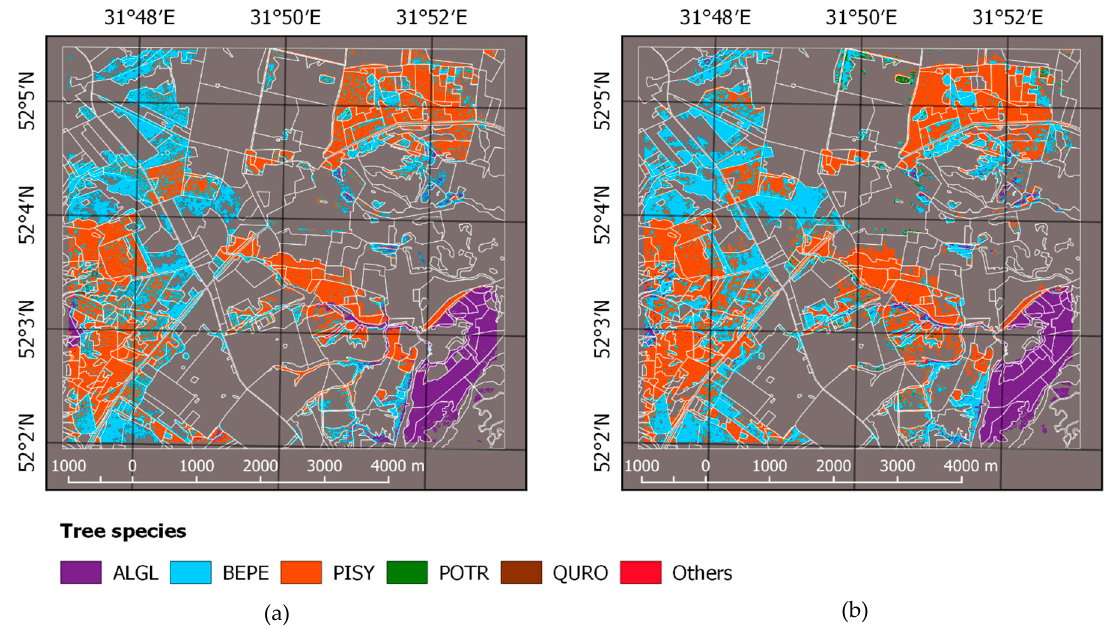
Forests 2019 , 10 , x FOR PEER REVIEW Figure A4. Tree species distribution within the study area mapped using satellite images: ( a ) RapidEye image for 2010; ( b ) SPOT 6 image for 2015.